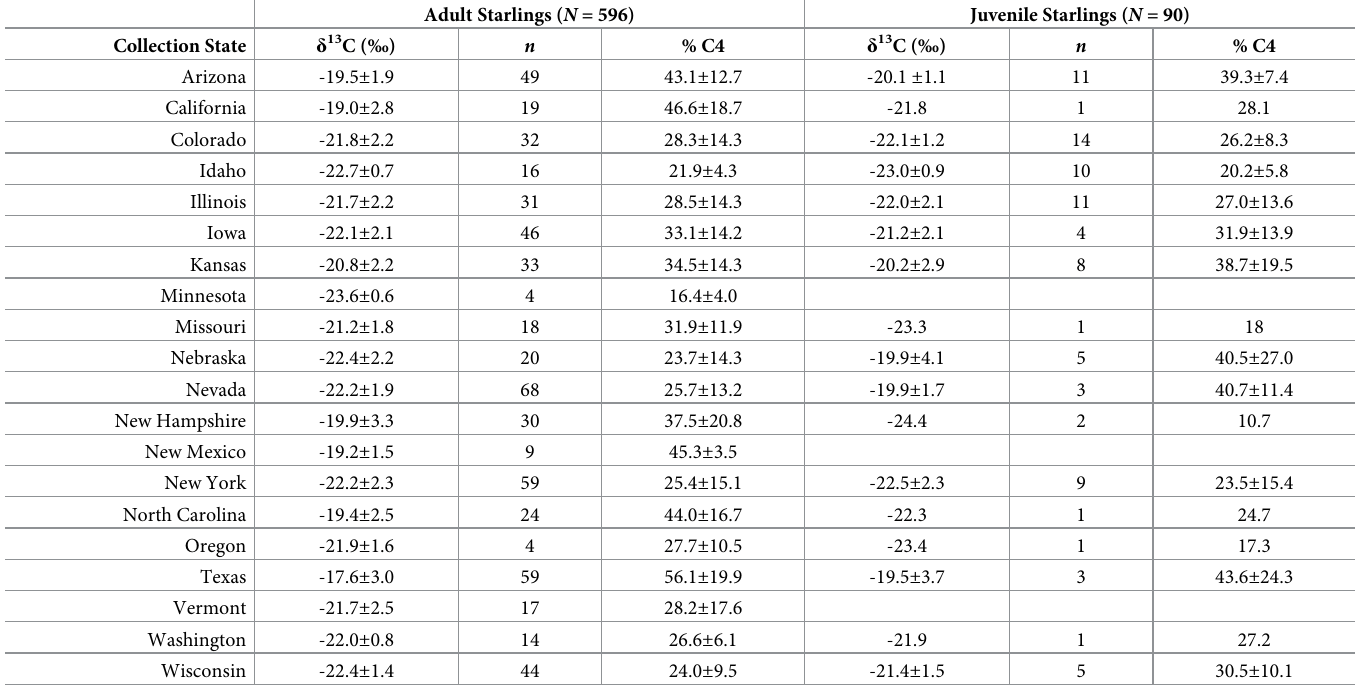
Table 4. Summary of derived percent C4 in diets of European starlings by collection state and age group. The model was based upon a simple two endpoint expecta- tion of a 100% C3 diet producing a feather δ 13 C value of -26.0‰ and that of a 100% C4 diet producing a feather δ 13 C value of -11.0‰ (after